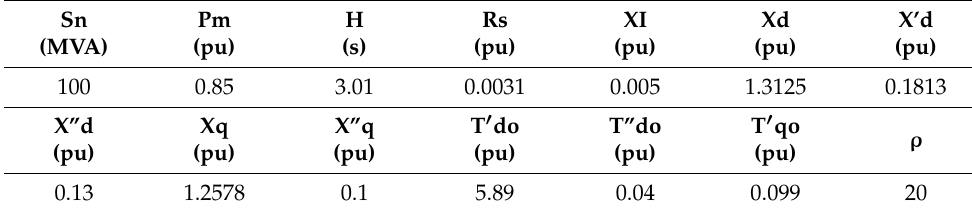
Table A5. Hydroelectric power plant parameters (synchronous generator).